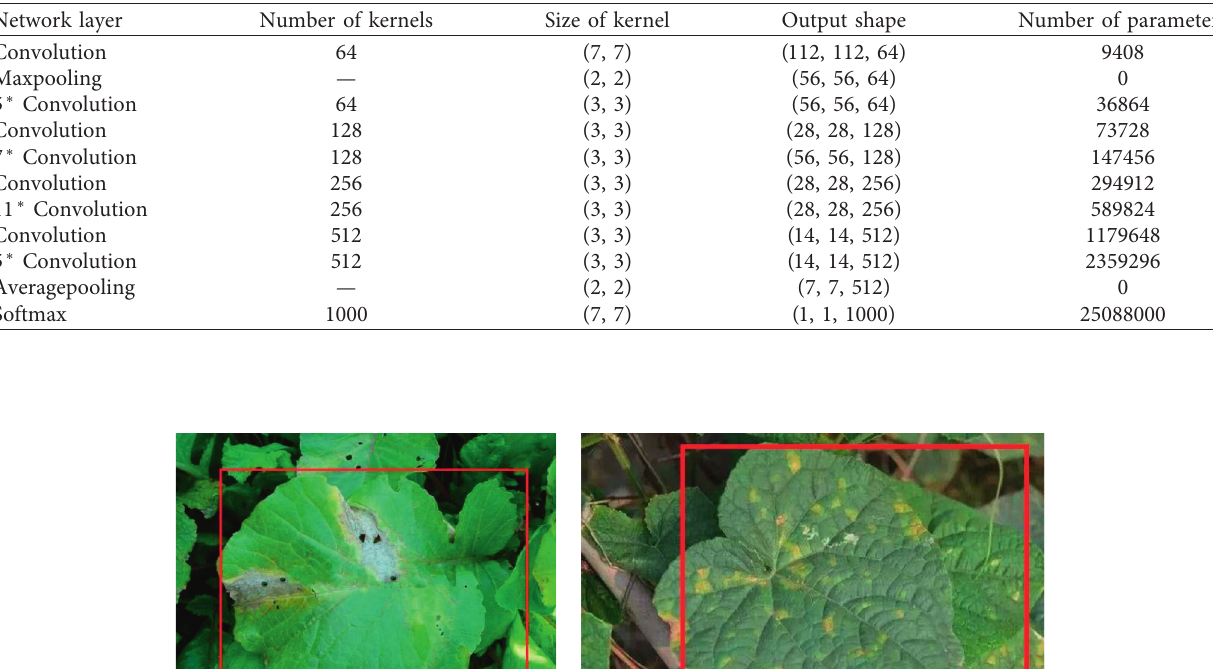
Table 3: The composition and parameter setup of ResNet-101.